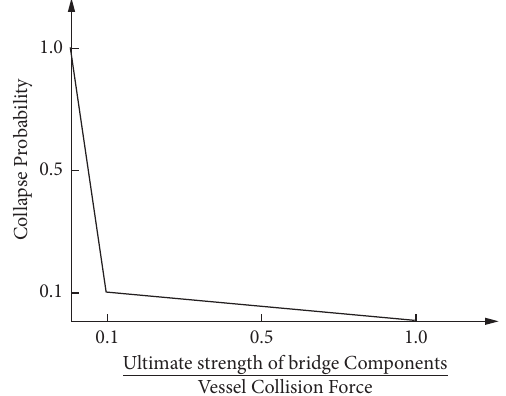
Figure 1: Distribution of collapse probability (AASHTO